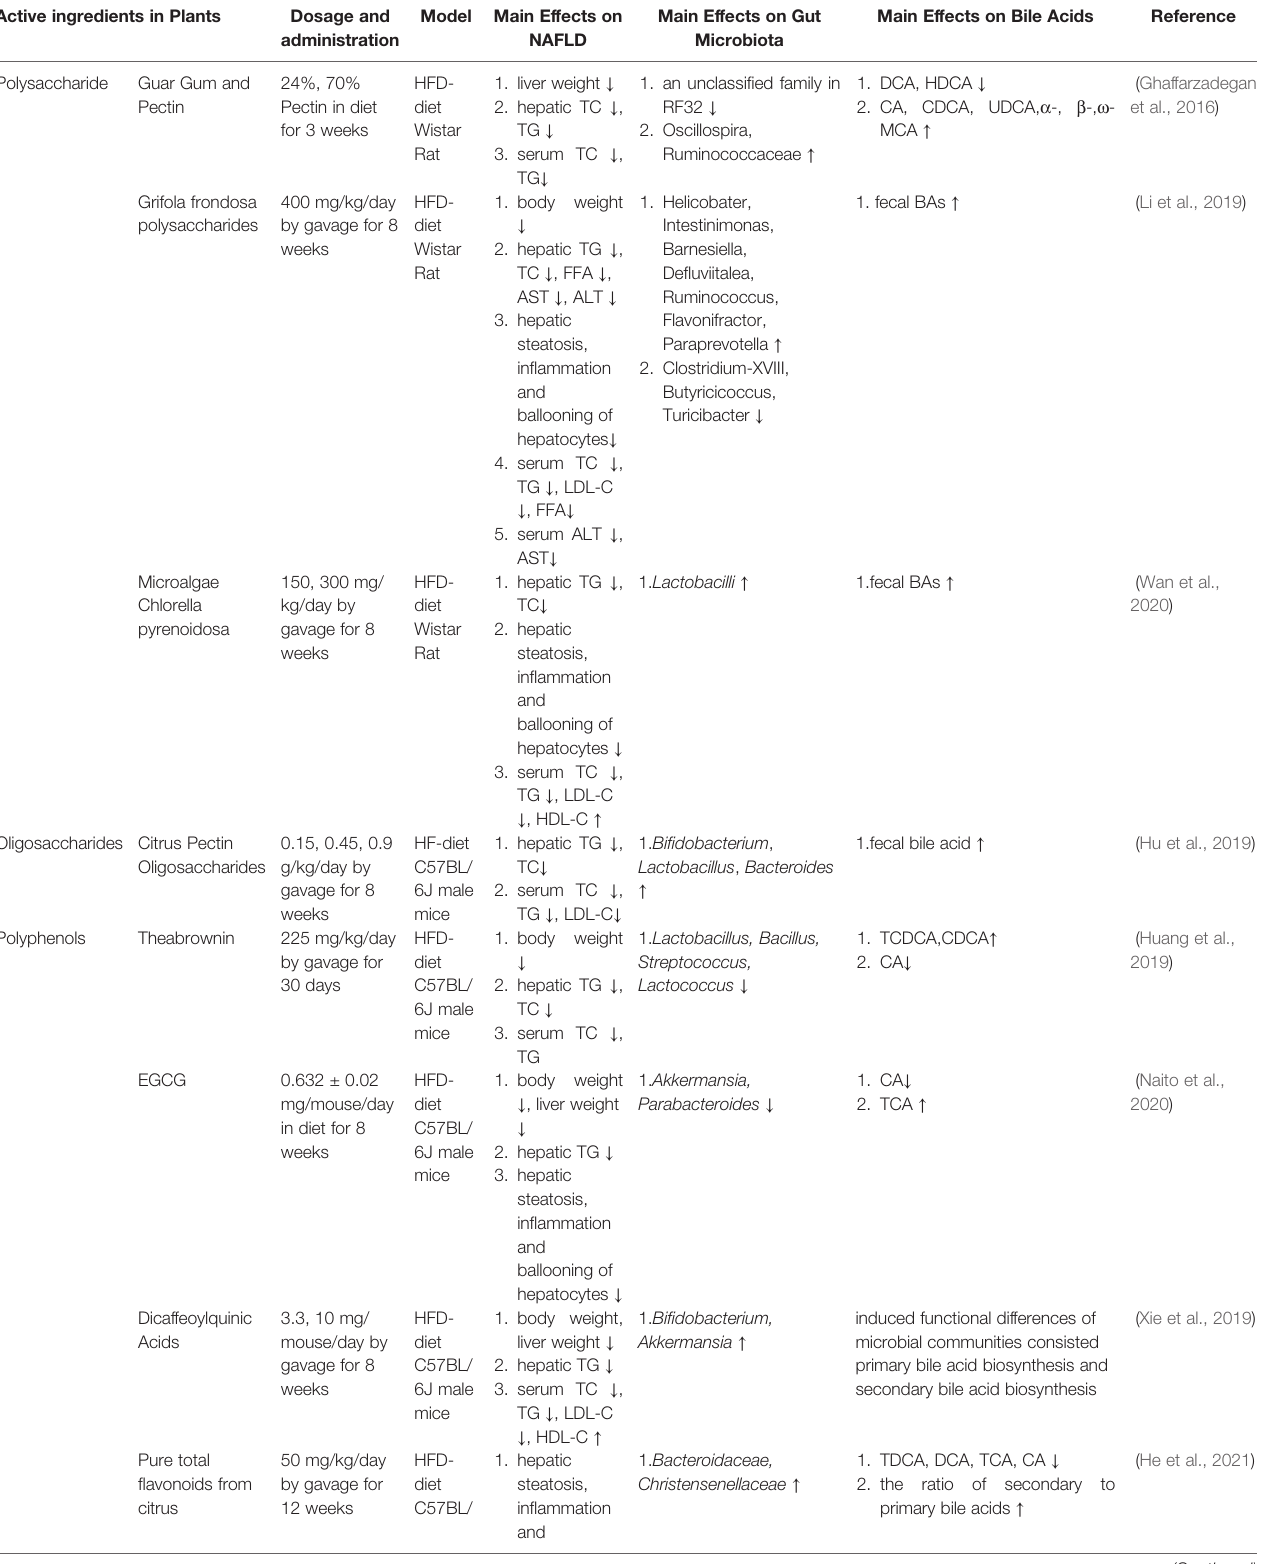
TABLE 2 | Active ingredients in natural plants regulate the interplay between GM and BAs in the treatment of NAFLD. Active ingredients in